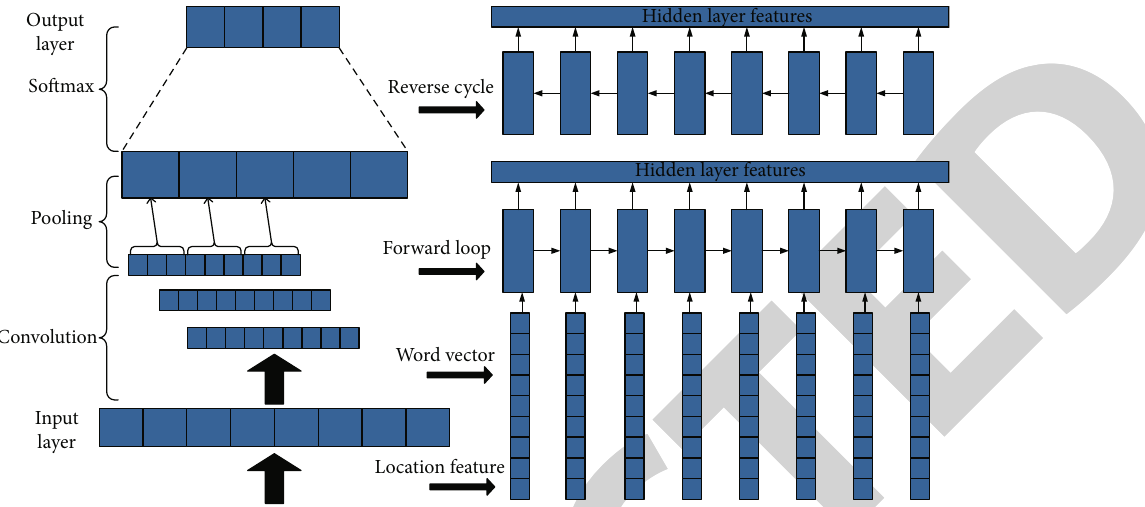
Figure 1: Neural network complex model structure